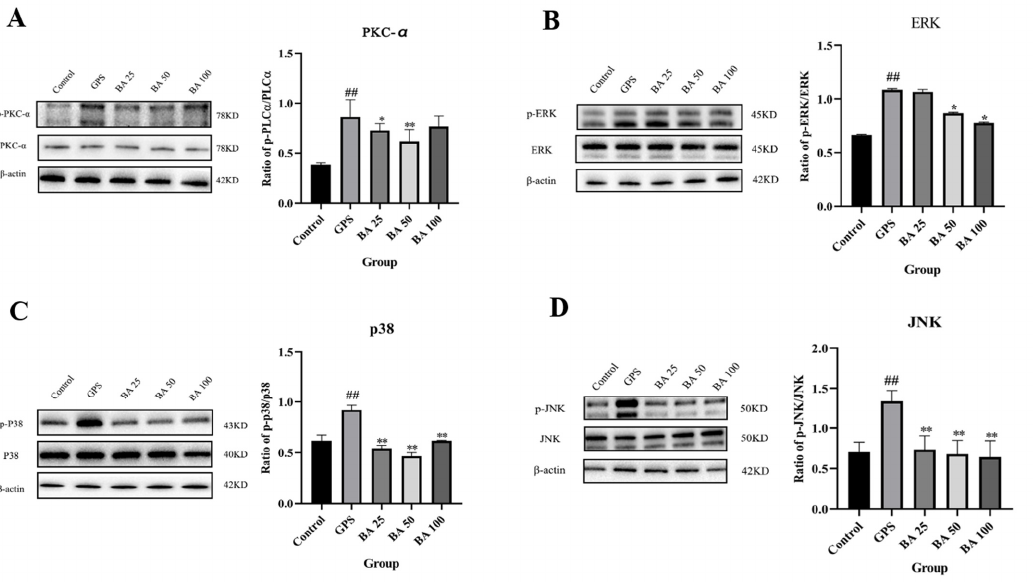
Figure 3. Inhibition effects of baicalin on PKC/MAPK signaling pathway in PMCC activated by GPS. PKC- α ( A ), ERK ( B ), p38 ( C) , JNK ( D ) (Mean ± SD, n = 3). GPS: G. parasuis group, BA 25: 25 mg/kg baicalin + G. parasuis group, BA 50: 50 mg/kg baicalin + G. parasuis group, BA 100: 100 mg/kg baicalin + G. parasuis group. ## p < 0.01 vs control. * p < 0.05 vs G. parasuis group, and ** p < 0.01 vs G. parasuis group.